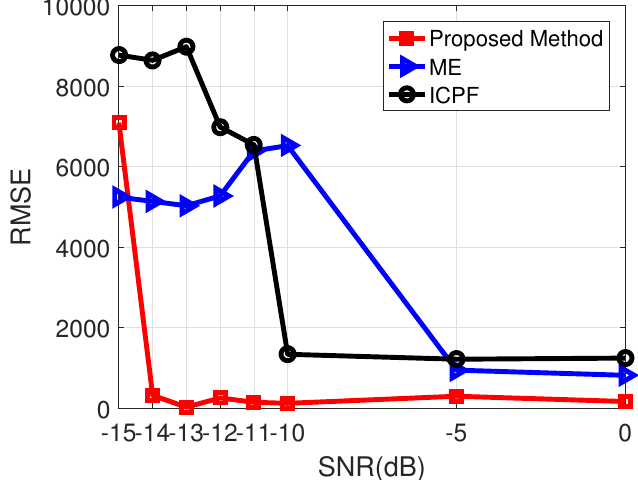
Figure 17. RMSE under different SNRs based on Yak-42 measured